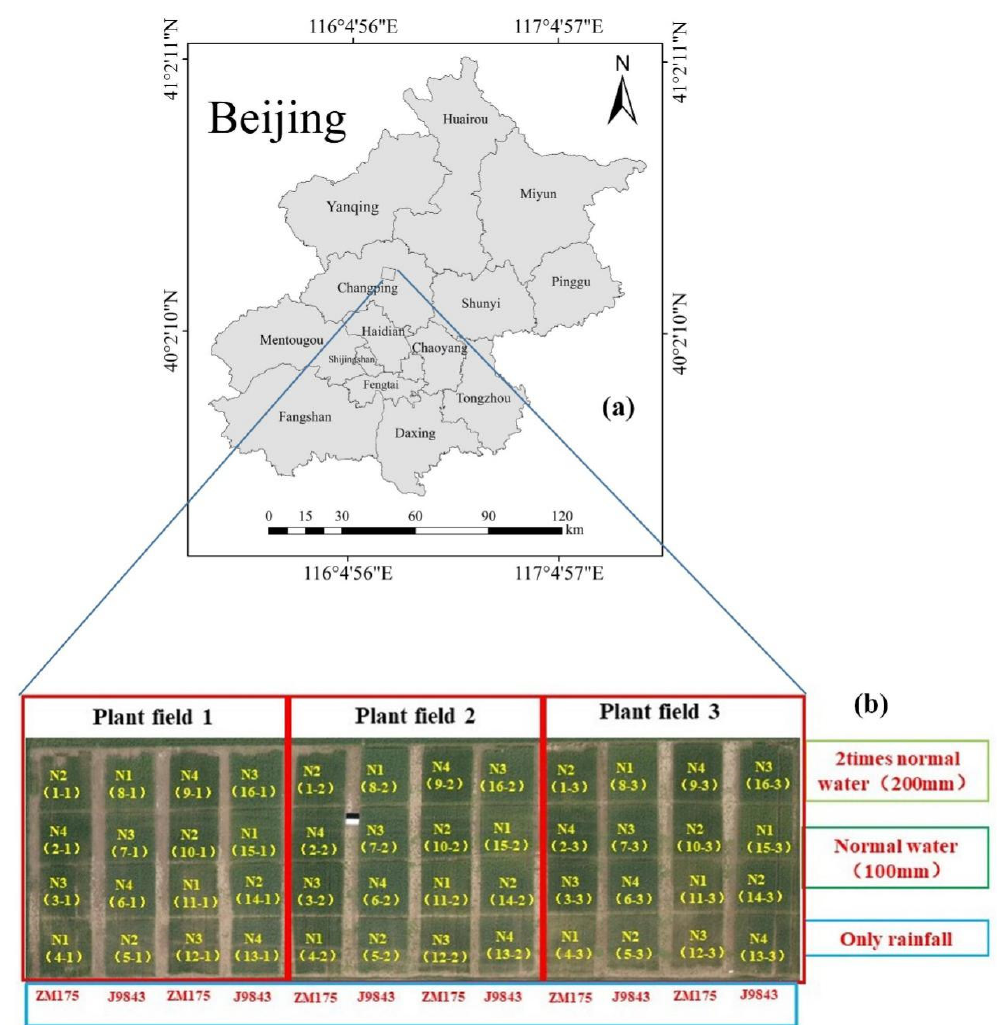
Figure 1. Test area location and experimental design: ( a ) location of Changping District in Beijing City; ( b ) design of experimental and images obtained by UAV.